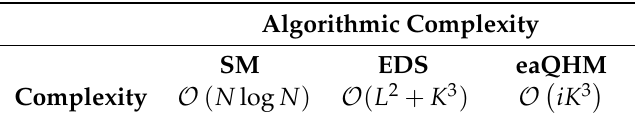
Table 4. Comparison of algorithmic complexity in Big-O notation. The table presents the complexity as a function of the size of the input N , L , and K and the number of iterations i . See text for